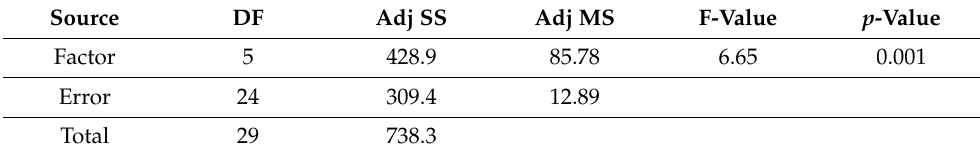
Table 1. ANOVA of the tensile strength of the hybrid jute–ramie reinforced epoxy.